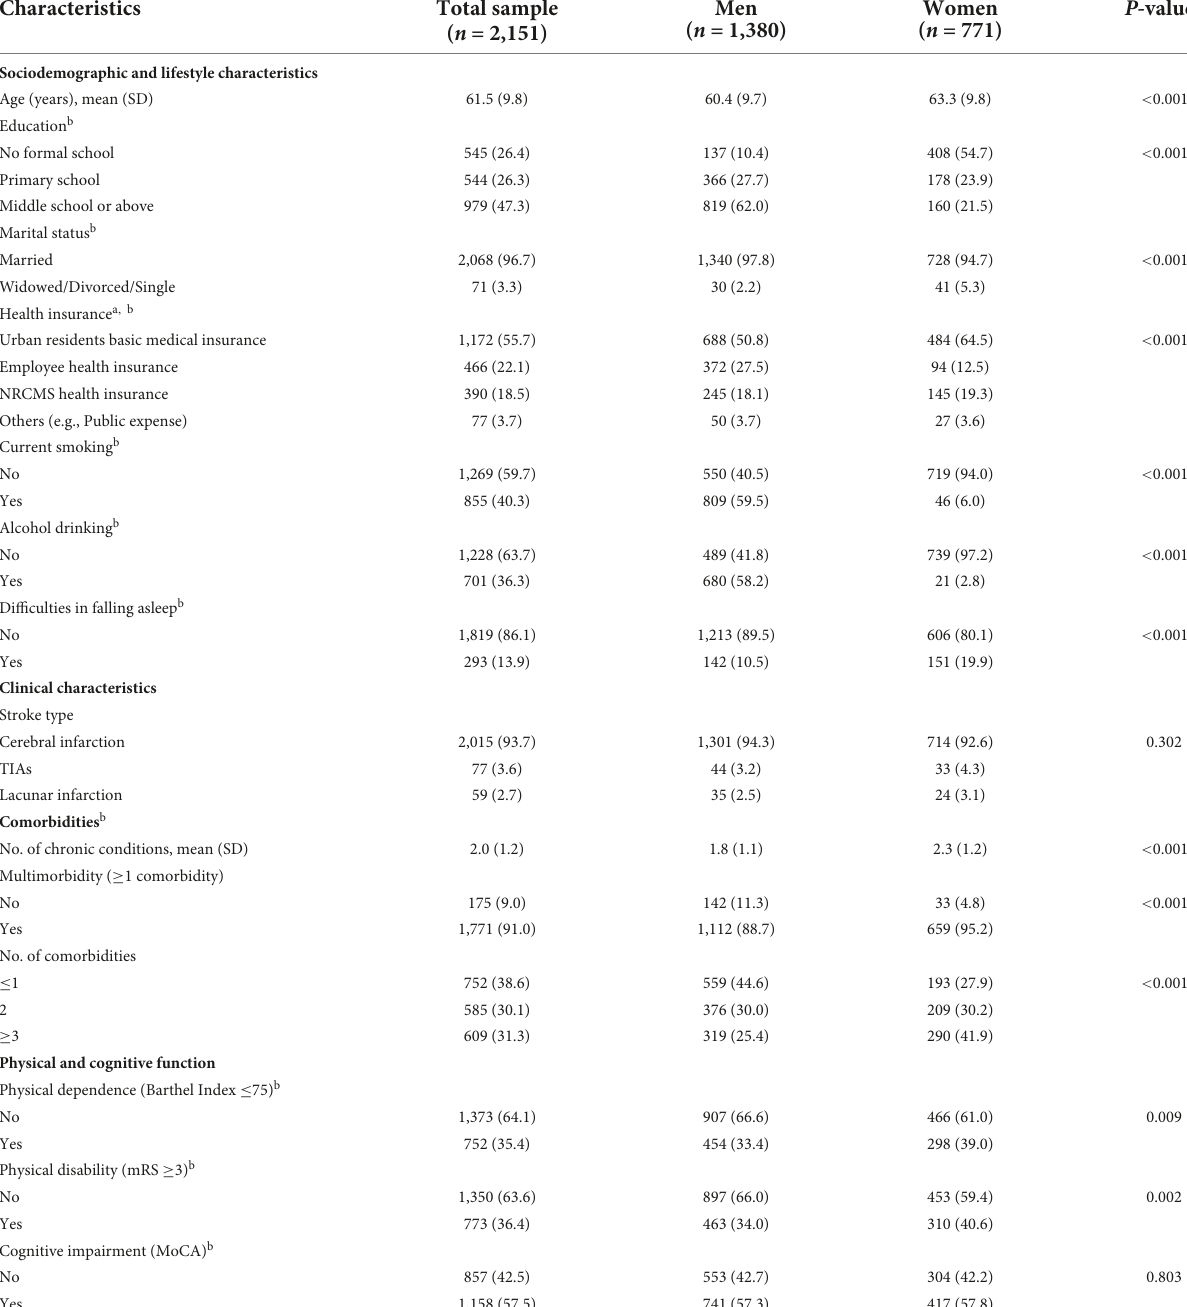
TABLE 1 Characteristics of the study